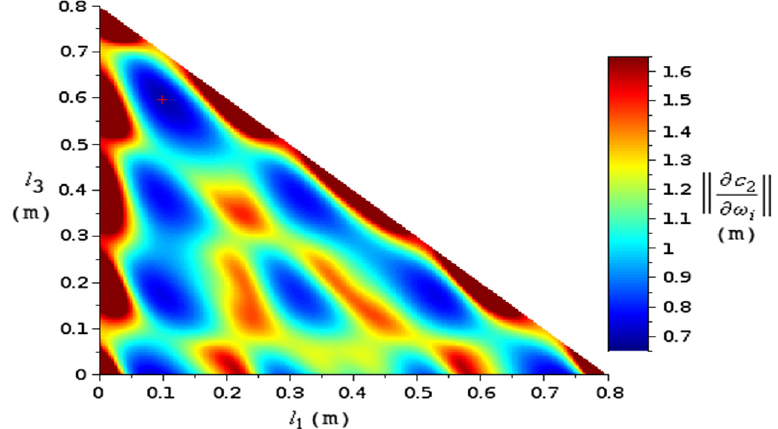
Figure 13. Map of the norm (22) in σ ( c 2 ) as function of l 1 and l 3 for a five-layer medium with two identical samples, with N = 4 resonances. The total length was fixed. The high values are trimmed at the edges. The absolute minimum is marked with a red “plus” sign.